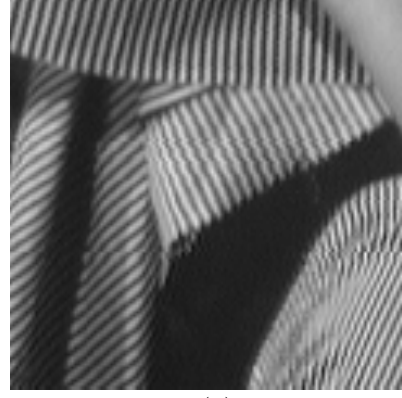
Comparison of subjective qualities in Barbara image: ( a ) original